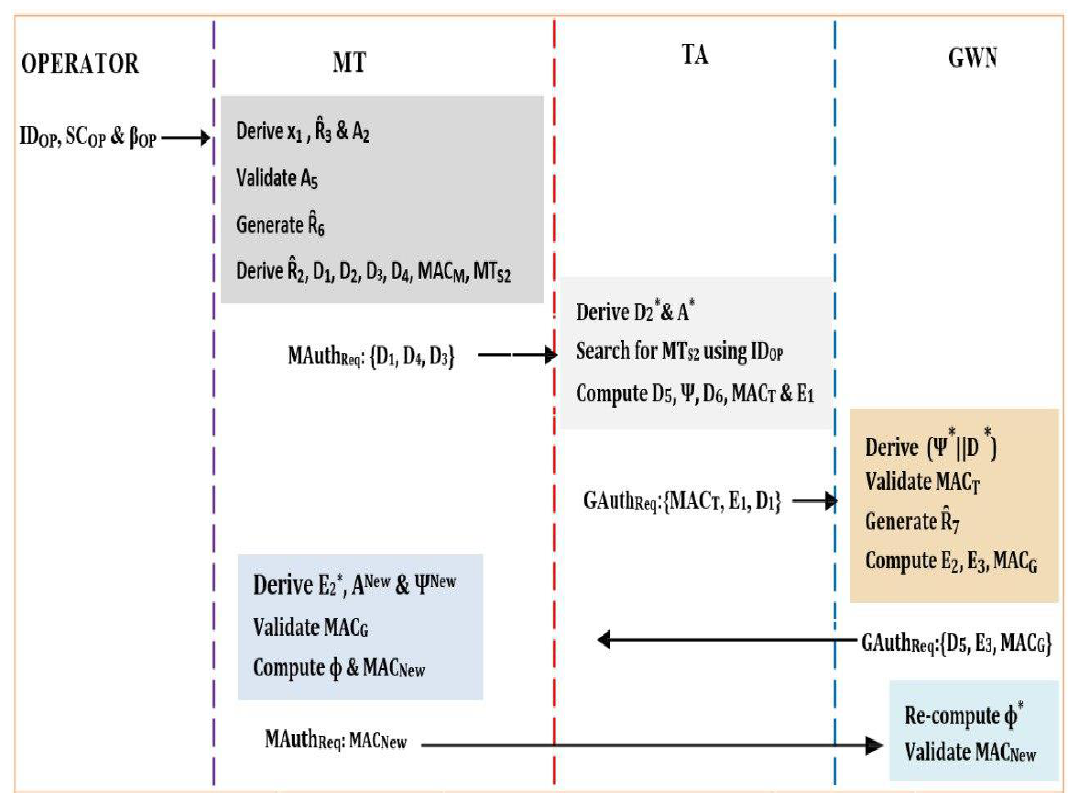
Figure 3. Authentication and key agreement message flows.